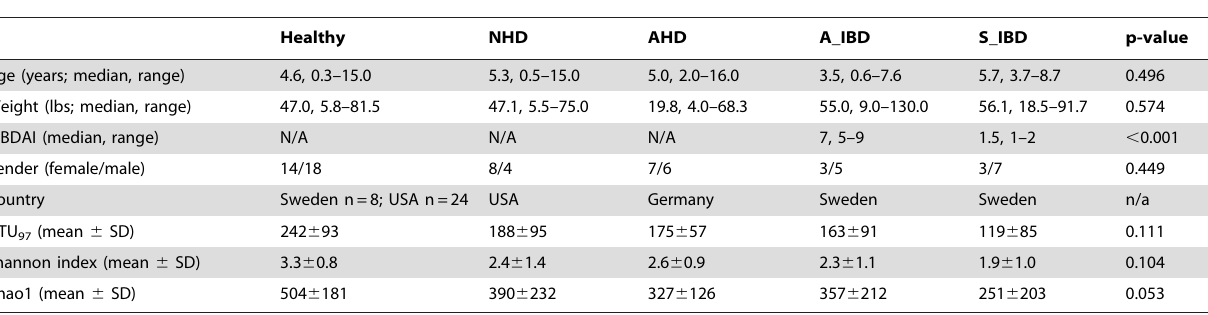
Table 1. Summary of basic characteristics and alpha diversity measures.